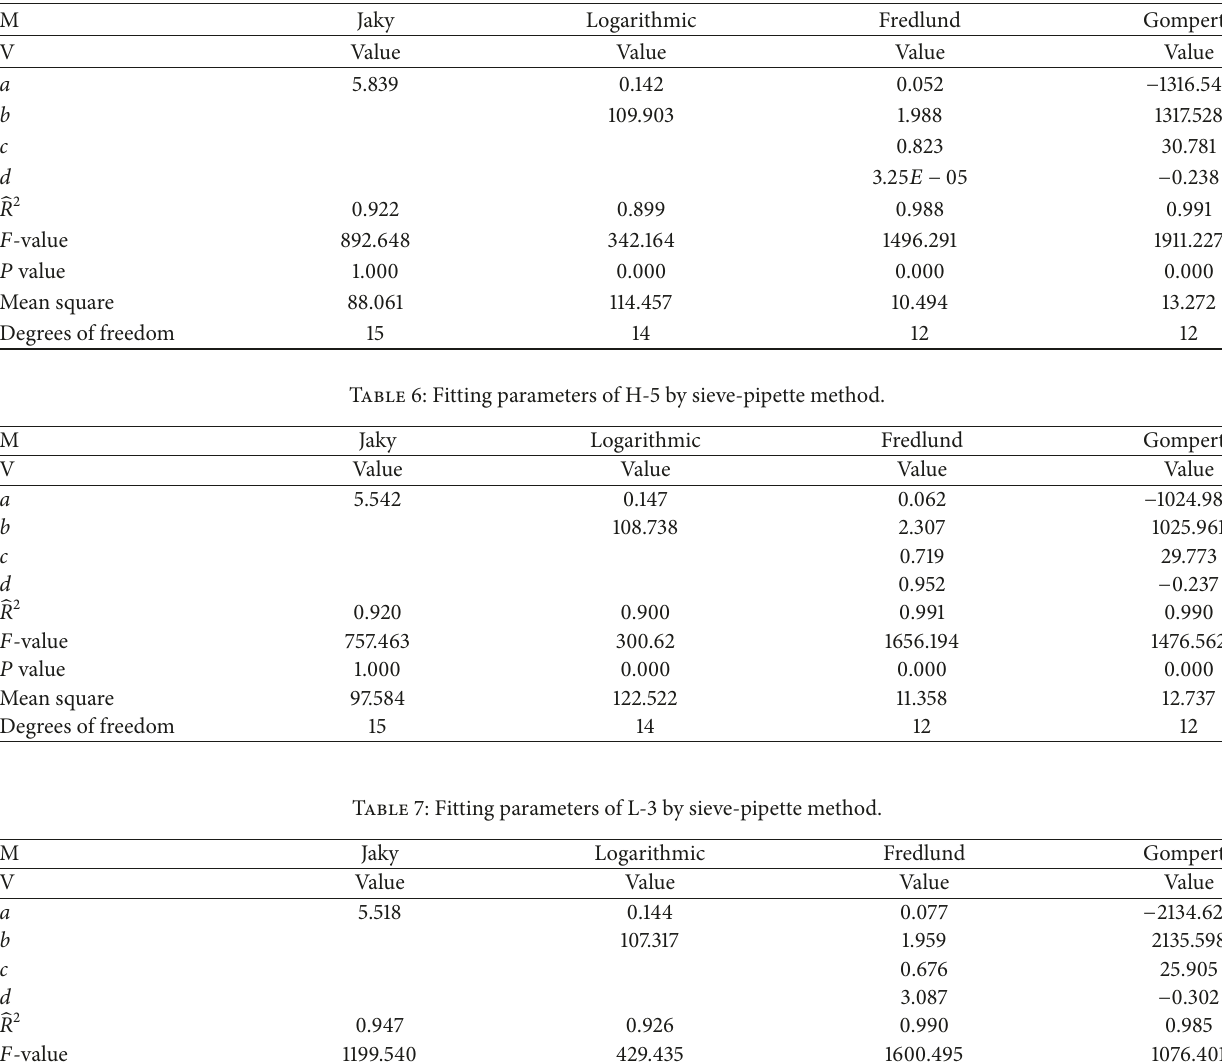
Table 5: Fitting parameters of G-7 by sieve-pipette method.